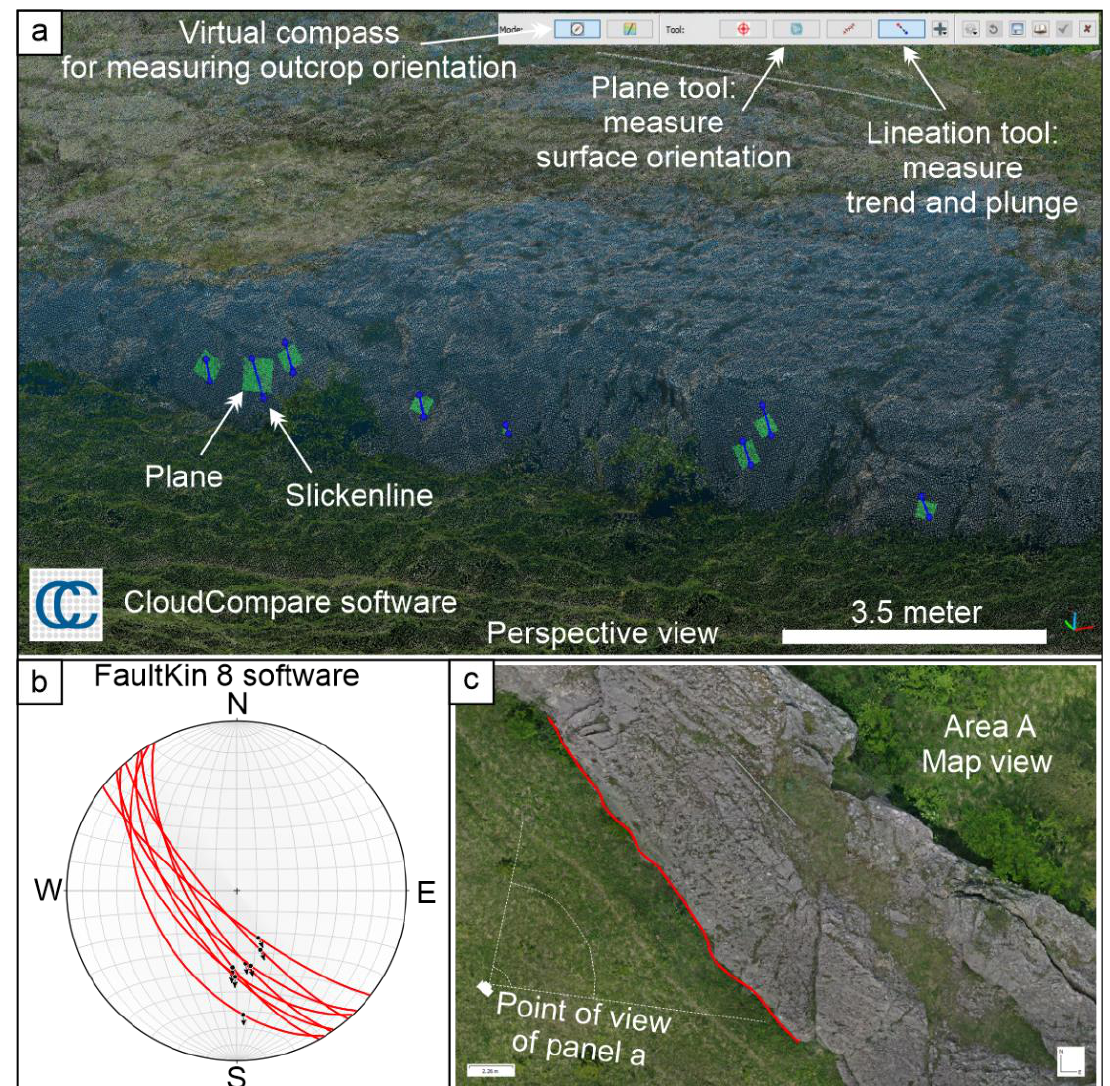
Figure 8. Examples of data acquired with the Virtual Compass tool from the dense cloud in Cloud- Compare ( a ) and represented with FaultKin 8 software ( b ); ( c ) map view of the fault plane measured in panel ( a